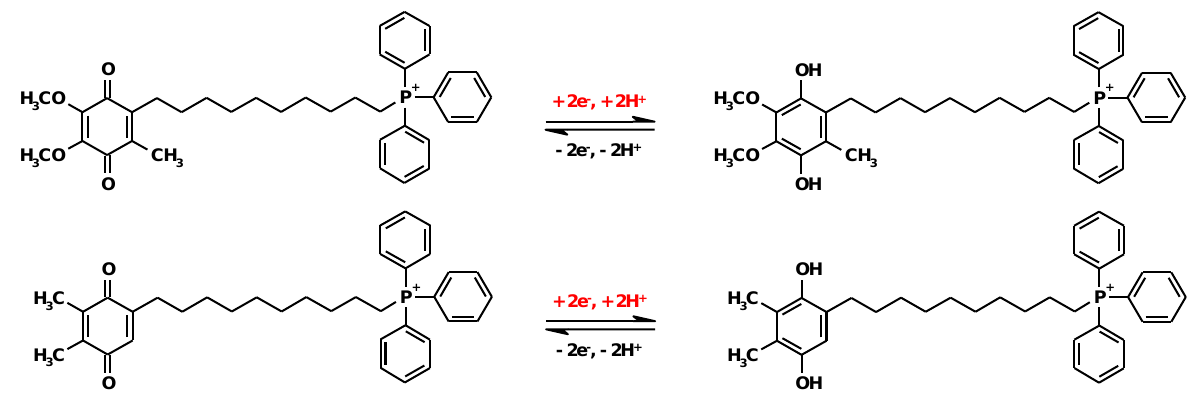
Scheme 3. The two electron reductive reactions of MitoQ (top reaction panel) or SkQ (bottom reaction panel) within a mitochondrion.